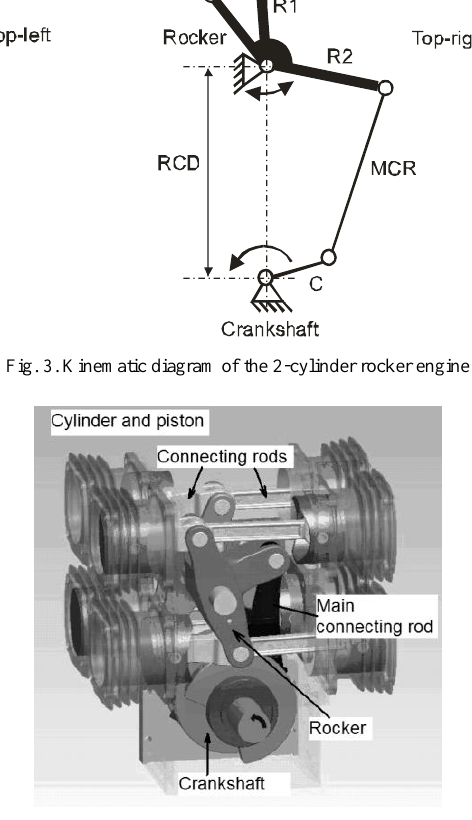
Fig. 4. Conception of the 8-cylinder rocker